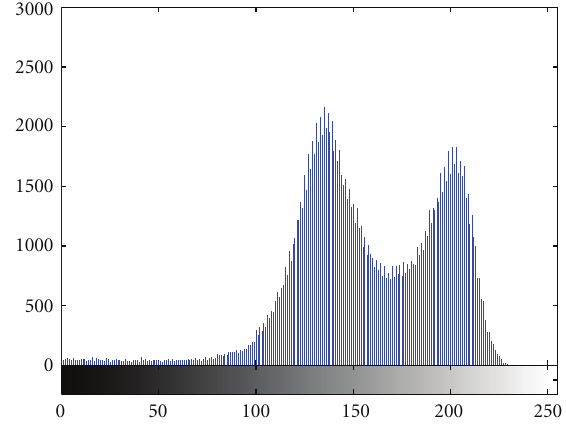
Figure 7: Gray histogram of the scanning images.